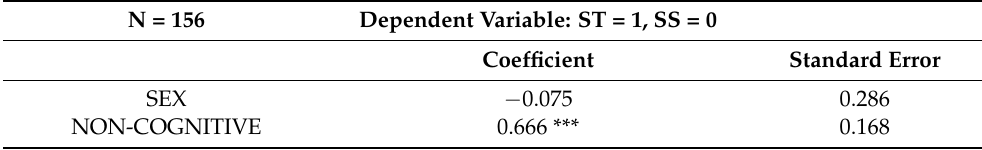
Table 7. Coefficients of a Probit model explaining the choice of the secondary education track. N = 156 Dependent Variable: ST = 1, SS = 0 Coefficient − 0.075